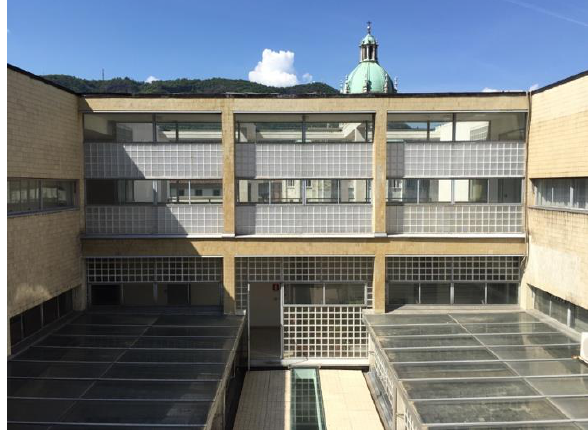
Figure 3. External atrium (Authors’ capture,